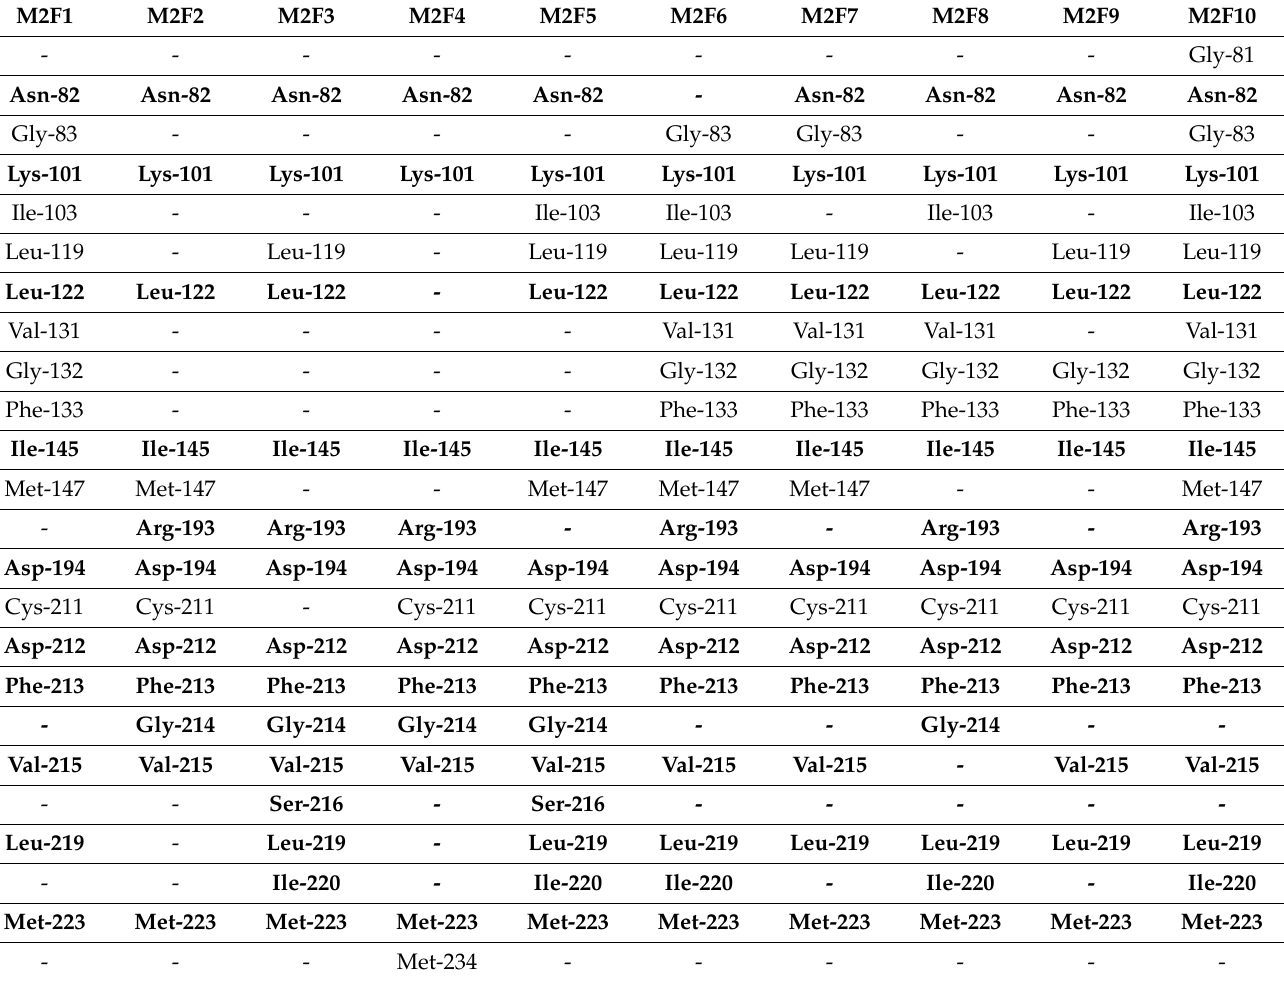
Table 1. Interacting residues of MEK2 for the ten proposed compounds. Each column contains interacting residues for the compound mentioned at the top of the column. The common interacting residues for different compounds are placed in the same row, and the interacting residues in common with the native ligand are in bold font.